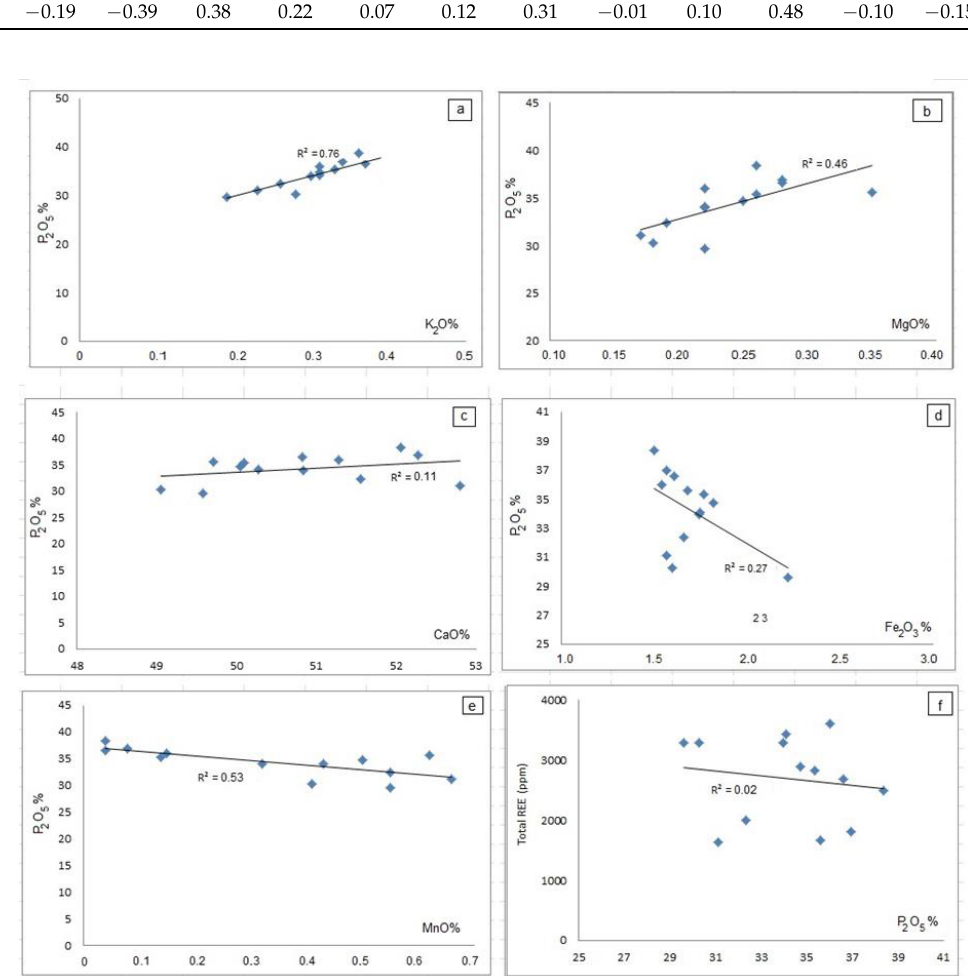
Figure 5. Binary major oxide plots: ( a ) P 2 O 5 vs. K 2 O; ( b ) P 2 O 5 vs. MgO; ( c ) P 2 O 5 vs. CaO; ( d ) P 2 O 5 vs. Fe 2 O 3 ; ( e ) P 2 O 5 vs. MnO; ( f ) total REEs vs. P 2 O 5.